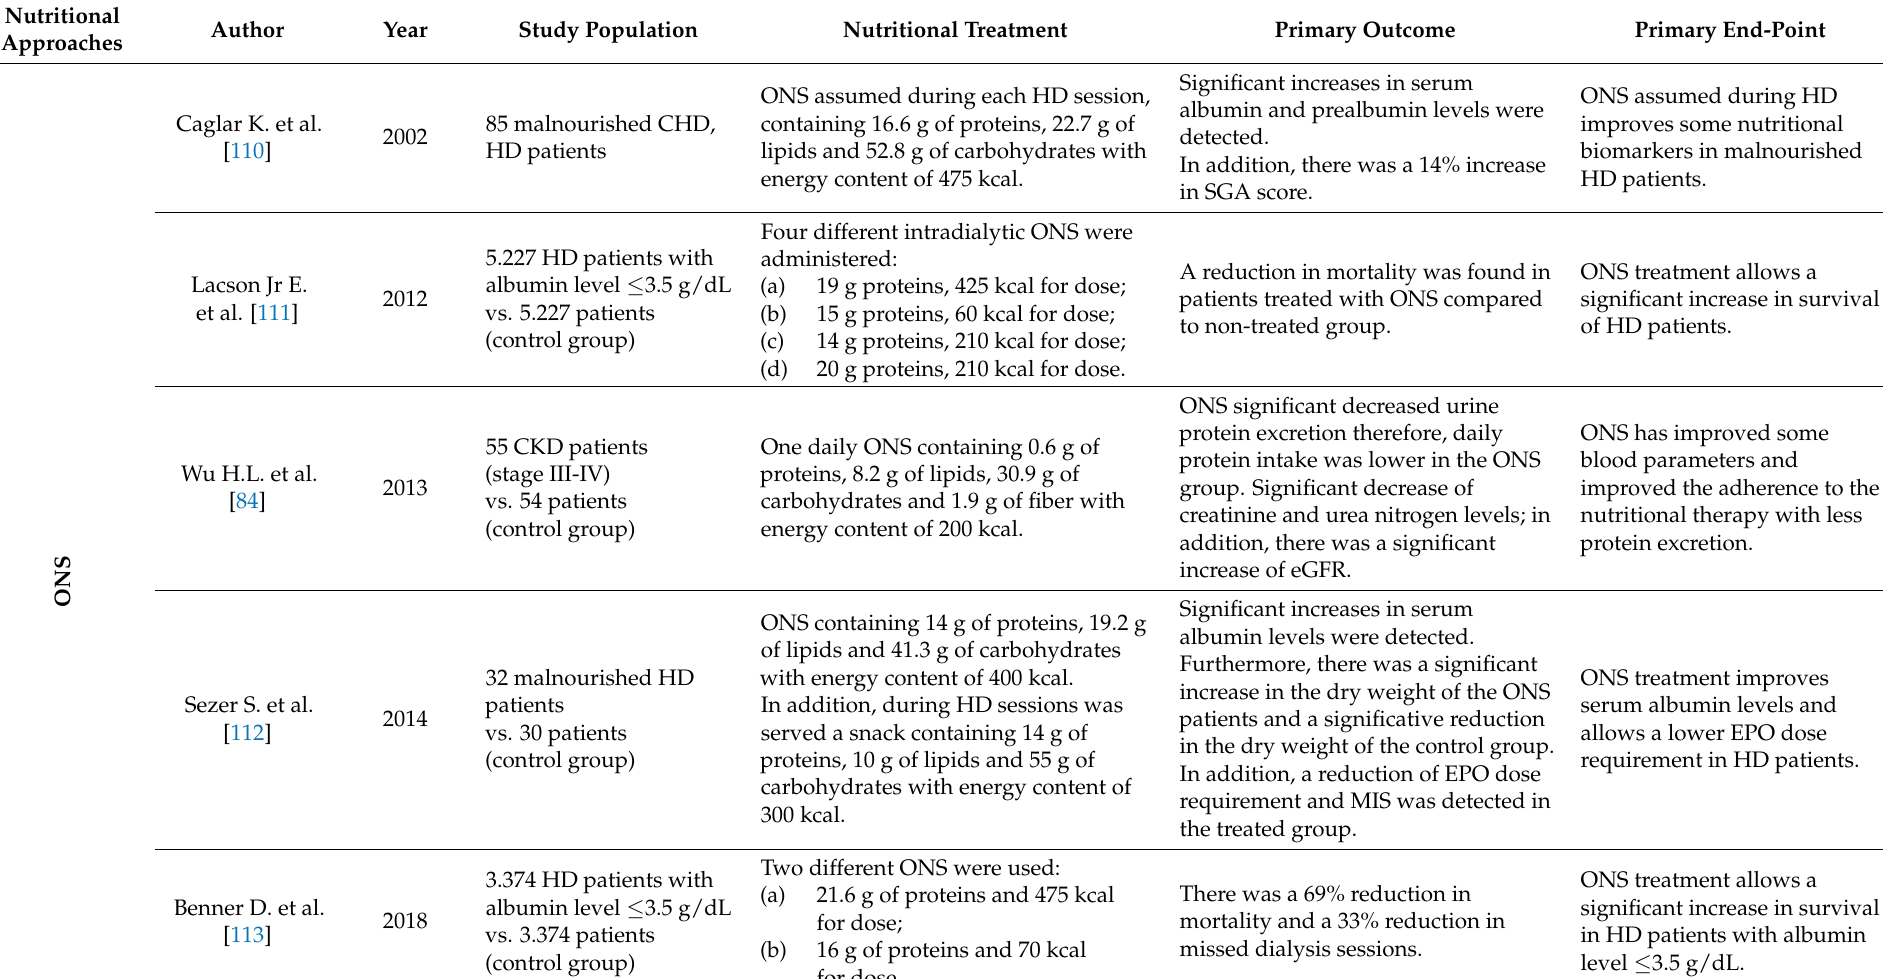
Table 1. Possible nutritional treatments of uremic sarcopenia in